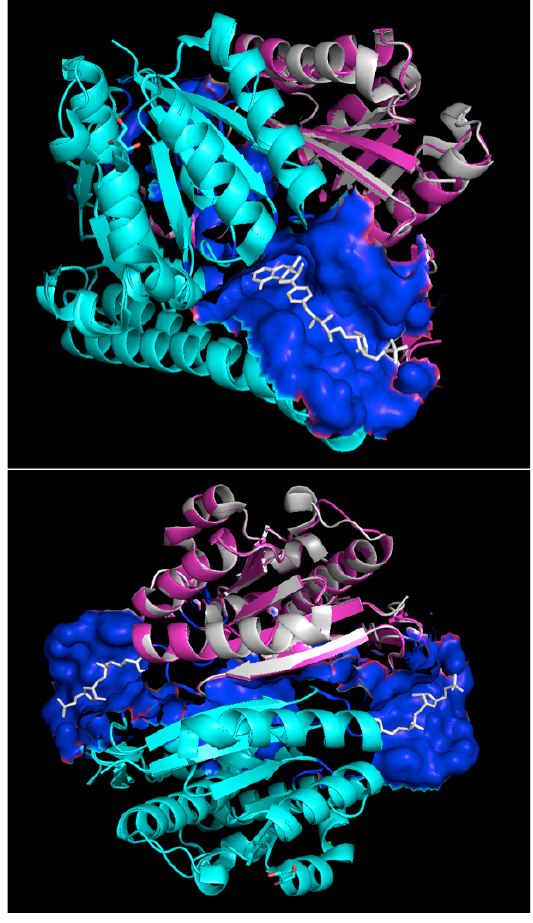
Figure 1. Modeled quaternary structure of A5UMI1 /3IQZB (cyan) and A5UMI1 /3IQZF (pink) after respective alignments onto chain-B and chain-F of 3IQZ within PyMOL 28 . 3IQZ’s chain-F is highlighted in silver. Dual chain model site residues (blue surface) were inferred from residues in chain-B and chain-F models that are within 7 Å of the 3IQZ ligand (H4M - white). 3IQZ’s chain-B and chain-F form a quaternary structure with two different H4M binding sites (bottom).